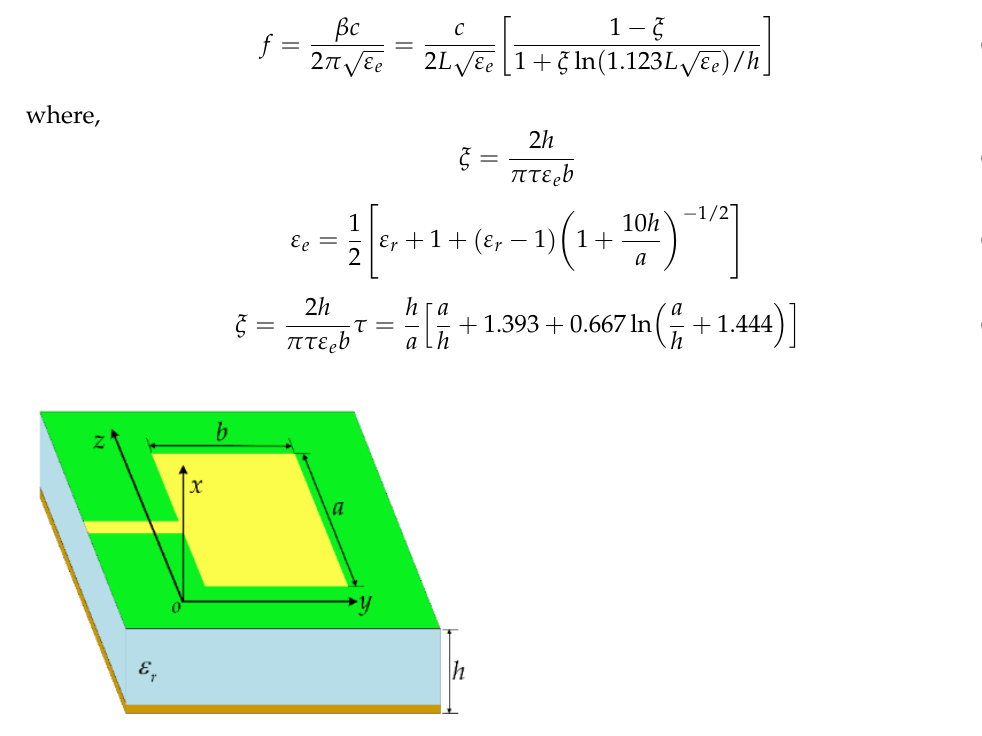
Figure 4. Rectangular microstrip antenna.